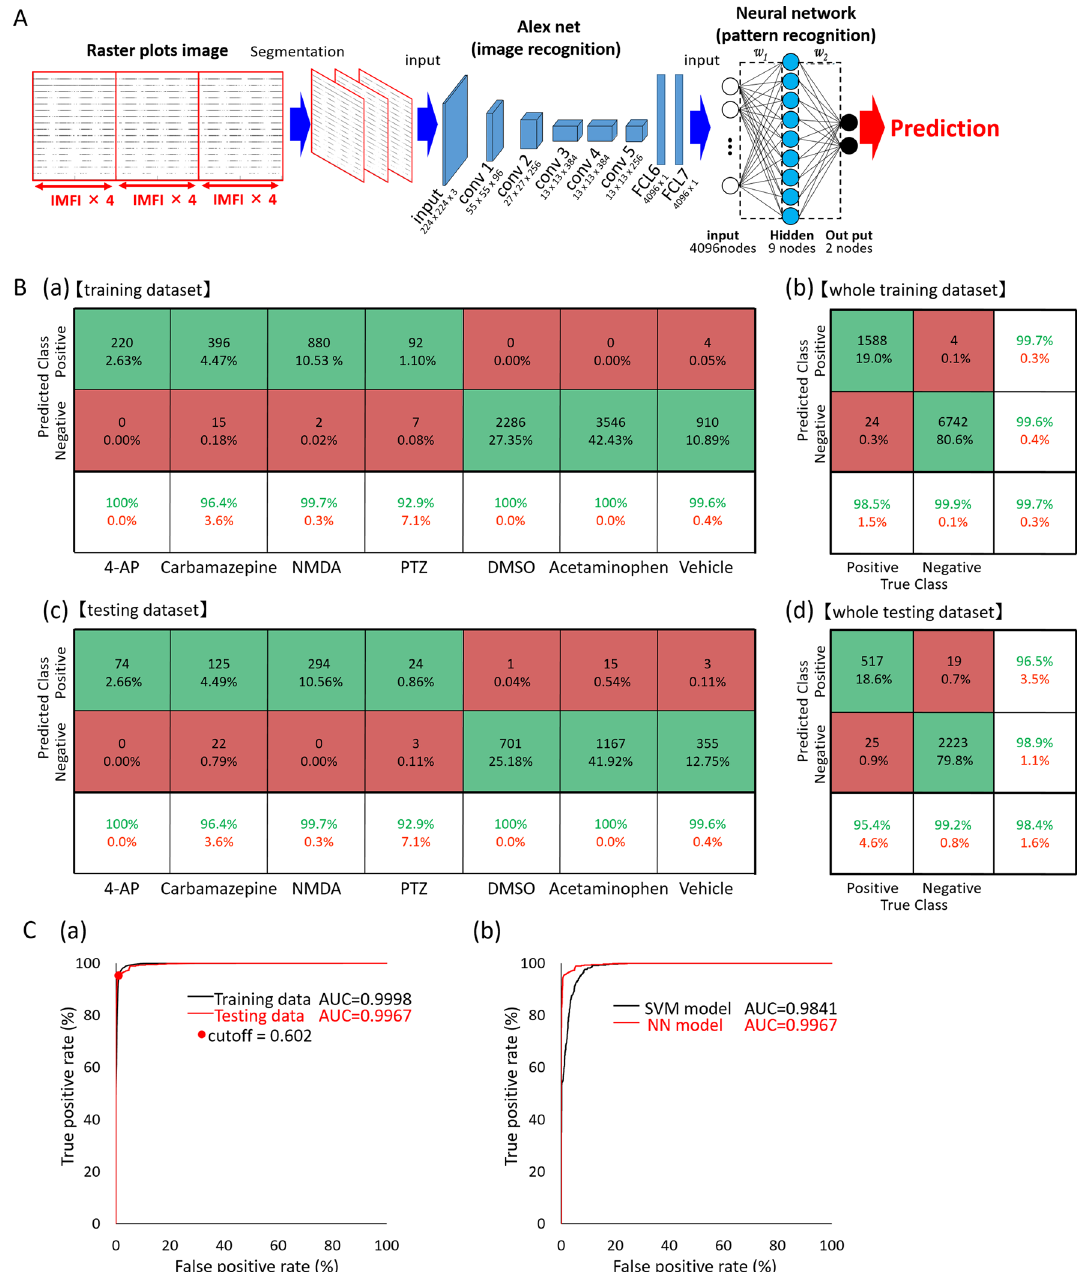
Figure 3. Creation of seizure risk prediction AI using raster plot images and evaluation of the prediction model. (A) Data flow and architecture of seizure risk prediction model. w1 is the weight between the input layer and the hidden layer, w2 is the weight between the hidden layer and the output layer. (B) (a) Confusion matrix for each compound used for training, (b) confusion matrix for the entire training dataset, (c) confusion matrix for each compound used for the test, (d) confusion matrix for the entire test dataset. The test dataset used the data of the wells not used for training dataset. Vehicle in the confusion matrix indicates vehicle data in four seizure-causing compounds. (C) (a) Receiver operating characteristic (ROC) curve after classification of training and testing data in a neural network model (black line: training data; red line: testing data; red dot: optimum operating point). (b) Comparison of ROC curves after classification of the same testing data in NN and SVM models (black line: SVM model; red line: NN